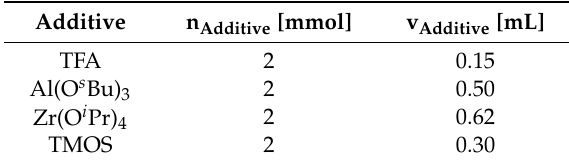
Table 1. Amounts of Additives in [K (1 − x ) Na x ]MgF 3 syntheses. Additive n Additive [mmol]